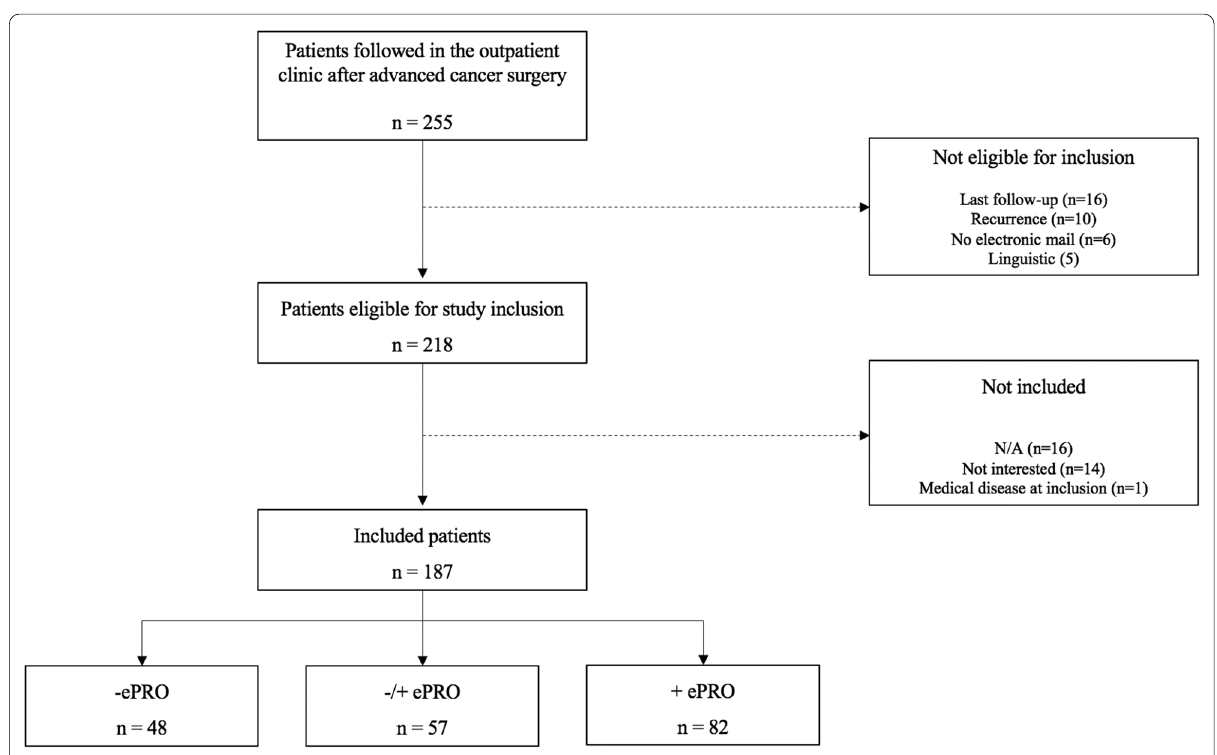
Fig. 2 Inclusion of patients throughout the period from 2017 to 2018 (N/A: not